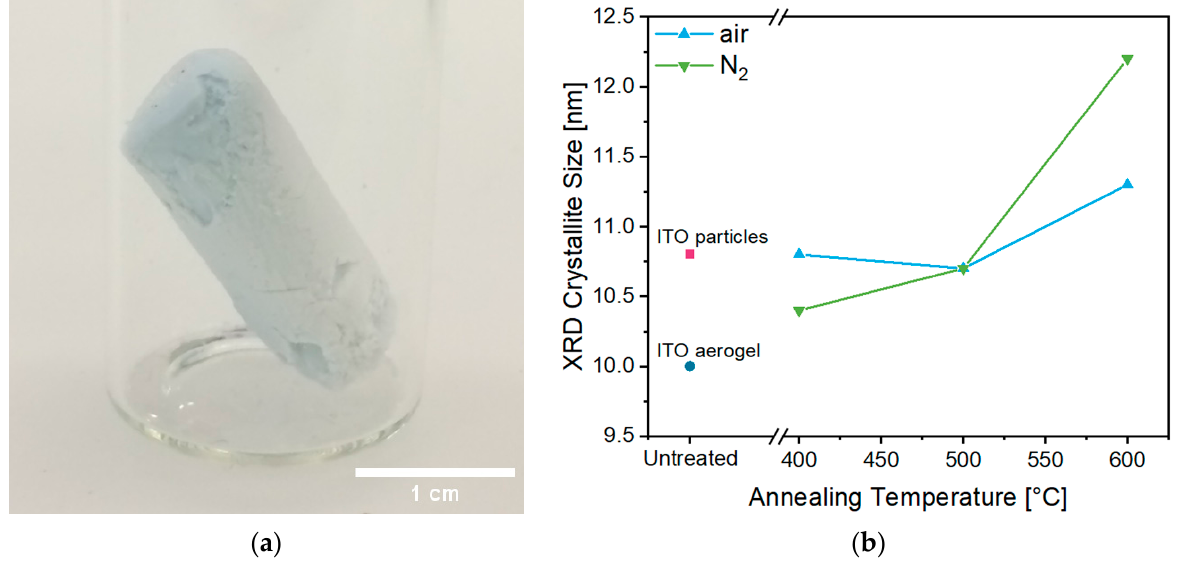
Figure 3. Photograph of an ITO aerogel A (15 at.% Sn) directly after CPD ( a ) and the calculated XRD crystallite size ( b ) of the washed and dried ITO product (rose square), the ITO aerogel (dark blue circle) after CPD and the calcined aerogels as a function of the annealing temperature in air (blue triangles) and N 2 (green diamonds).